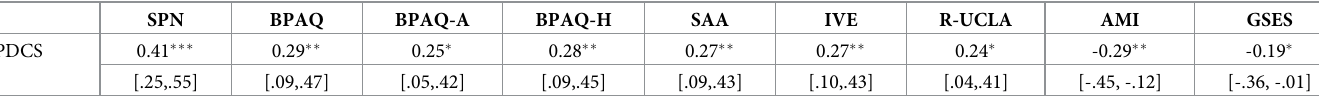
Table 6. Correlation coefficient of the PDCS and the results of other research instruments 1